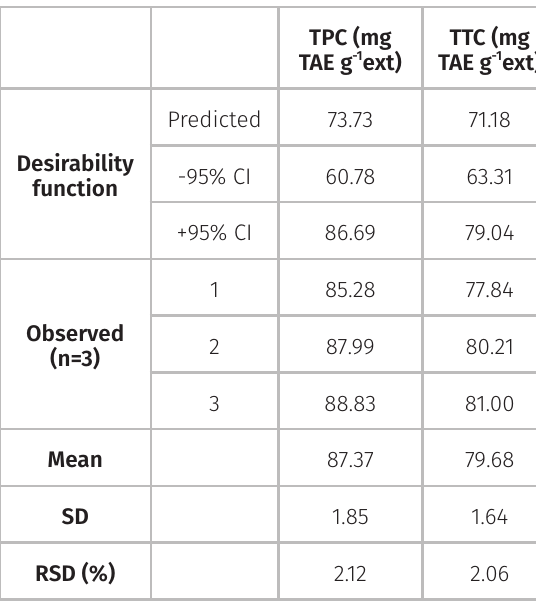
Table IV. Values estimated by the desirability function compared to the experimental results (n=3) at the optimized condition where X w), X = 0.6 (1/34 g/mL) and X 3 level was established as